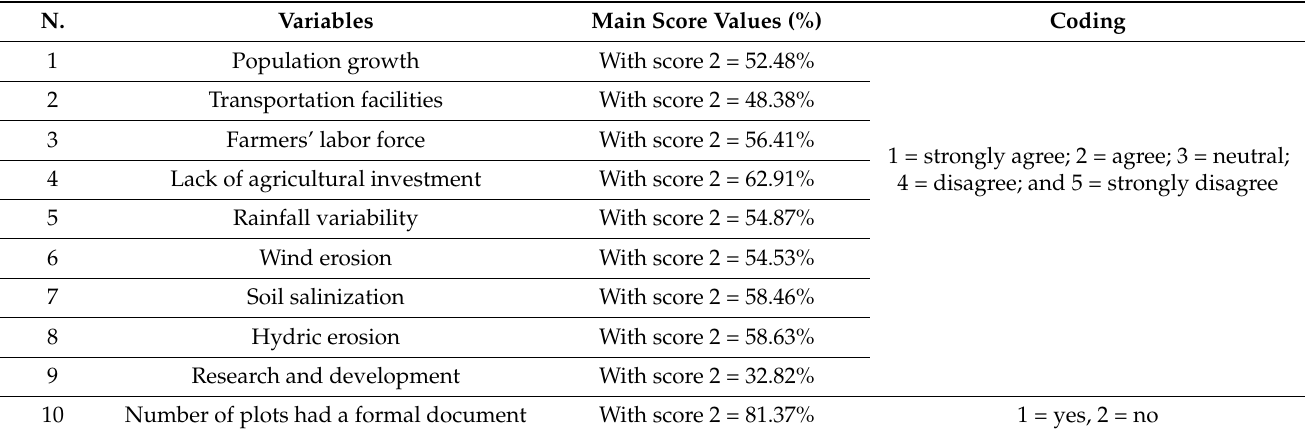
Table 3. Description of the potential driving force of agricultural land use